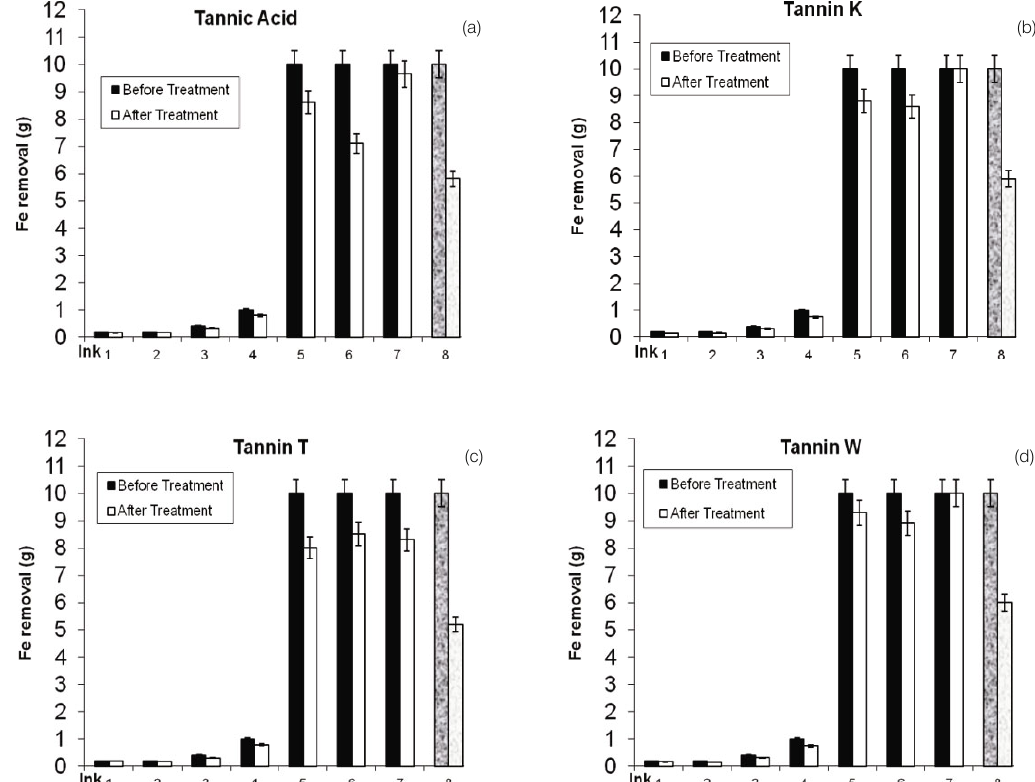
Figure 3. Iron removal from thermally aged iron-gall inks after treatment with calcium phytate solution. (Bars represented as Ink 8 correspond to percent copper removal from Ink 7). Inks prepared using: (a) Tannic Acid; (b) Tannin K; (c) Tannin T; and, (d) Tannin W. Table 3. Percent Fe(II) removal after accelerated thermal aging, followed by treatment with calcium phytate solution (thermally aged paper strips containing iron-gall